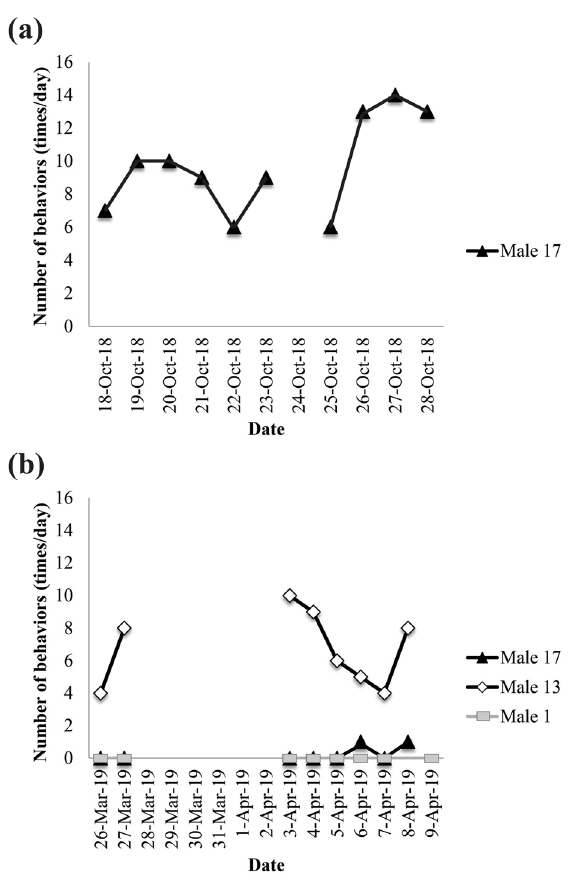
Figure 4. Difference in the number of urine sprays depending on the release method. ( a ) The frequency of urine spraying observed when only Male 17 was released and had exclusive use of the enclosure. ( b ) The frequency of urine spraying when Males 17, 1, and 13 were alternately and sequentially released into the enclosure normally used by Male 13. The daily observation time was 25 min after